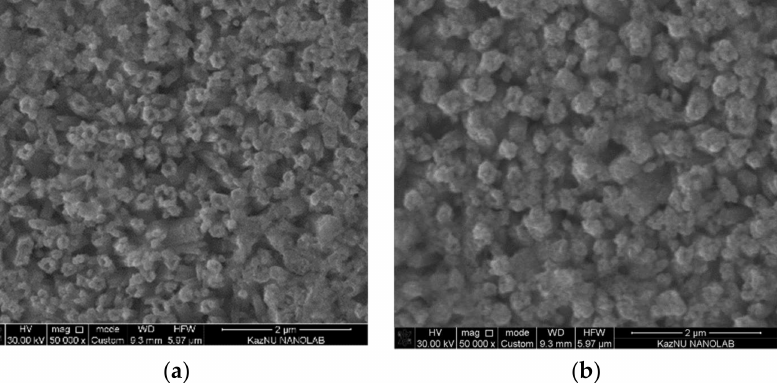
Figure 4. SEM images of composite materials of ZnO/Ag/CdS tubular forms: ( a ) 10 layers; ( b ) 20